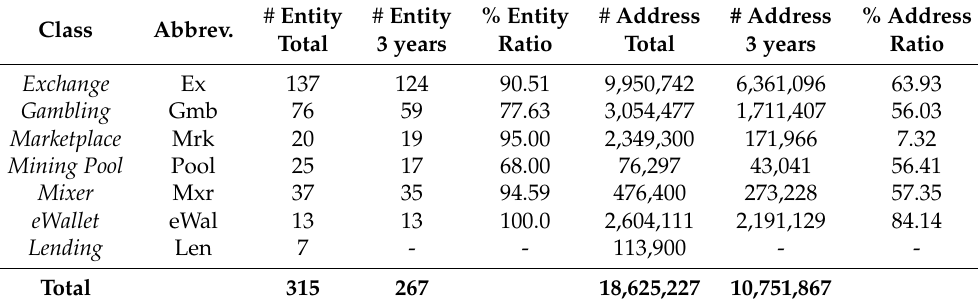
Table 1. Overview of WalletExplorer entities and address